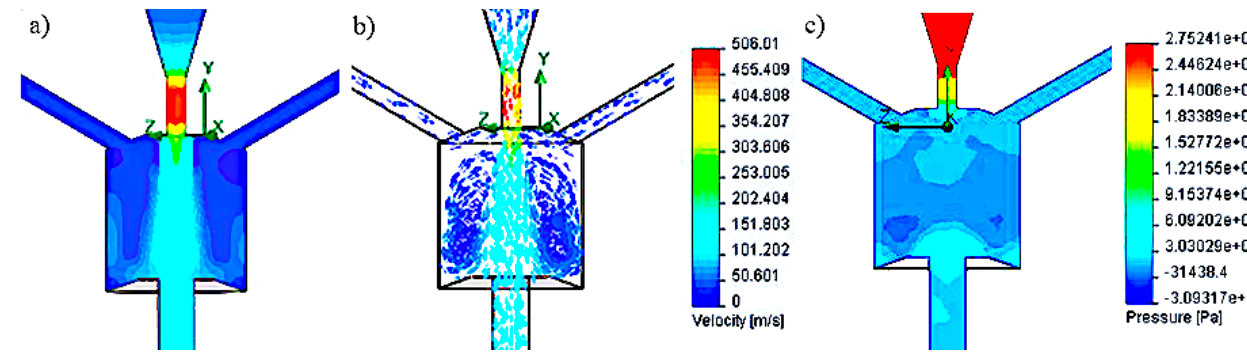
Figure 3. Distribution test results: ( a , b ) speed and ( c ) pressure inside the self-excited pulse head with side openings located at an angle of 120 ◦ (H = 20 mm, D = 20 mm, d 2 = 3 mm, d 3 = 5 mm, λ = 110 ◦ , h 1 = 8 mm), for a nominal pressure of 150